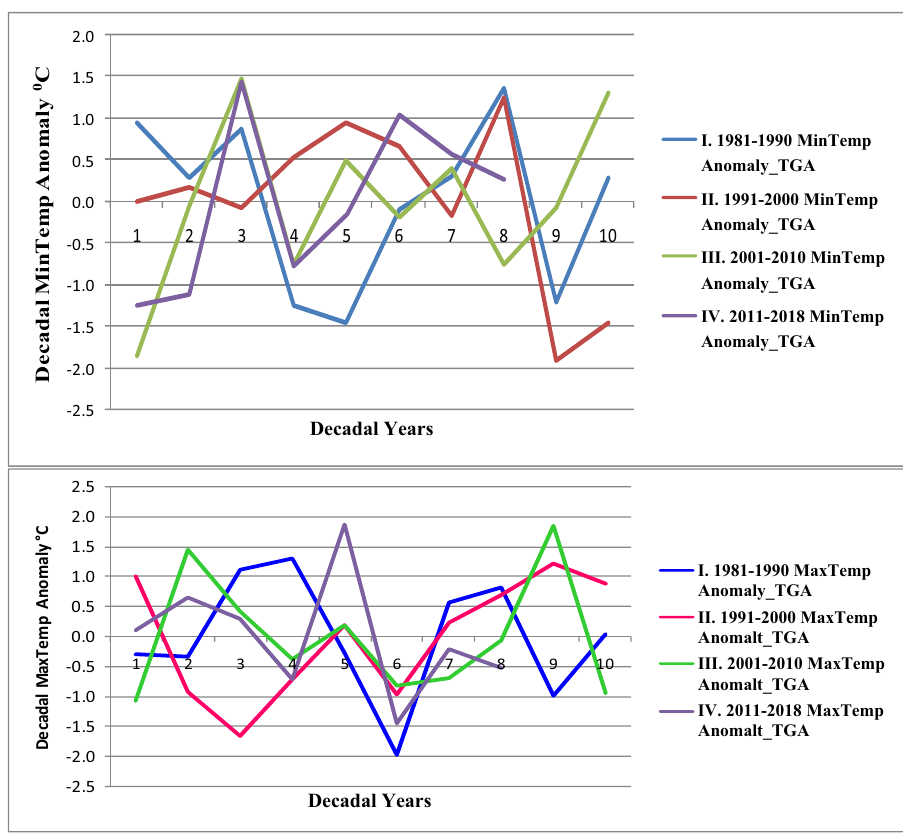
Figure 9: Decadal minimum and maximum temperature anomalies in te ff growing areas.